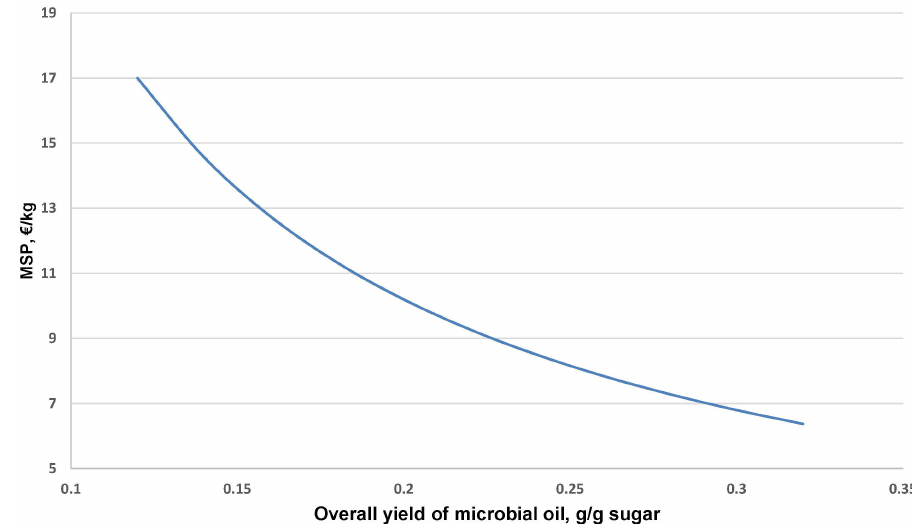
Figure 5. Influence of overall microbial yield on the microbial oil